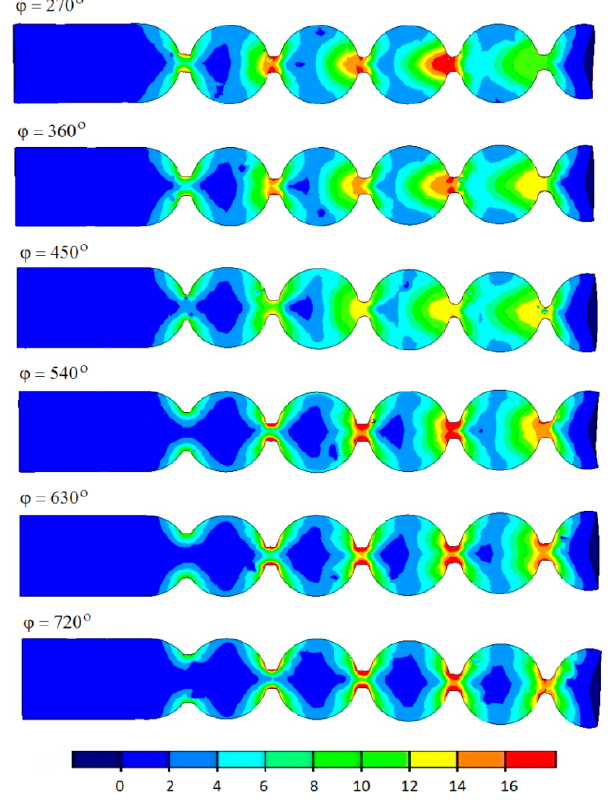
Figure 10. Effective strain in the axial section of semi-finished balls manufactured by helical rolling.